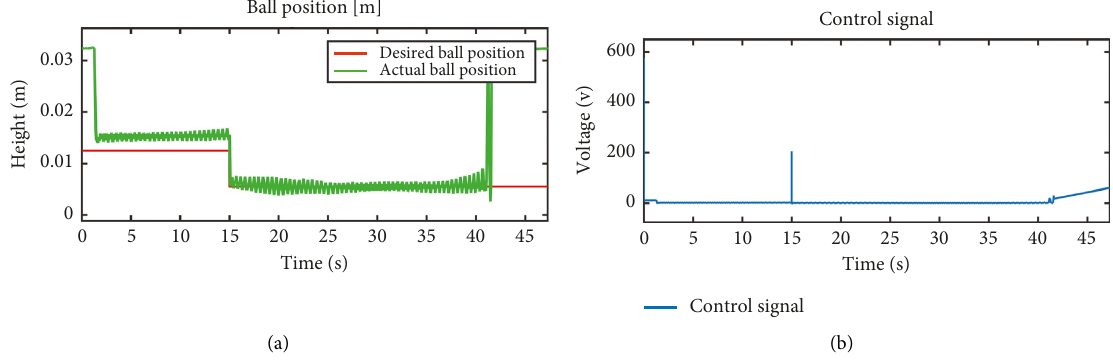
Figure 6: STEP output and control signal for the LQR controller.